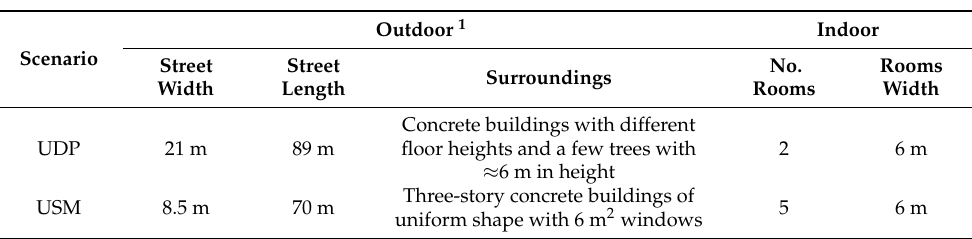
Table 2. Measurement Campaign